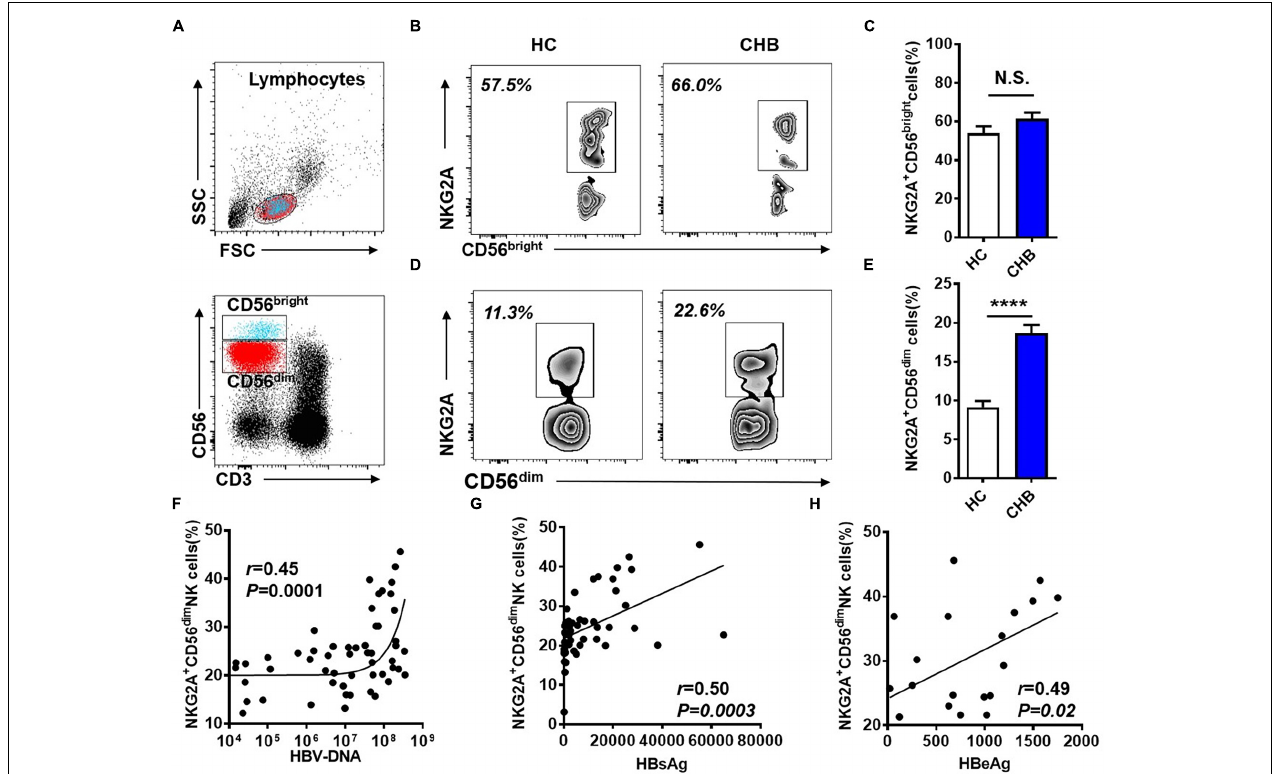
FIGURE 2 | Upregulation of NKG2A on CD56 dim NK cells and its positive correlation with HBV DNA levels. (A) Sequential strategy for gating CD56 dim and CD56 bright NK cells from lymphocytes with monitoring via flow cytometry. (B,C) Representative data plots show NKG2A expression on CD56 dim and CD56 bright NK cells in healthy controls and patients with CHB. (D) NKG2A + CD56 bright NK cells and (E) NKG2A + CD56 dim NK cells were detected in peripheral blood samples from patients with CHB and healthy controls. (F) Correlation between the percentage of NKG2A + CD56 dim NK cells and serum HBV-DNA levels in patients with CHB. (G) Correlation between the percentage of NKG2A + CD56 dim NK cells and serum HBsAg levels in patients with CHB. (H) Correlation between the percentage of NKG2A + CD56 dim NK cells and serum HBeAg levels in patients with CHB. Data are representative of more than three independent experiments. Results are presented as the mean ± SEM ( n ≥ 3 per group) and unpaired two-tailed Student’s t- tests or Spearman’s correlation coefficients were used for analyses; **** p < 0.0001; N.S., not